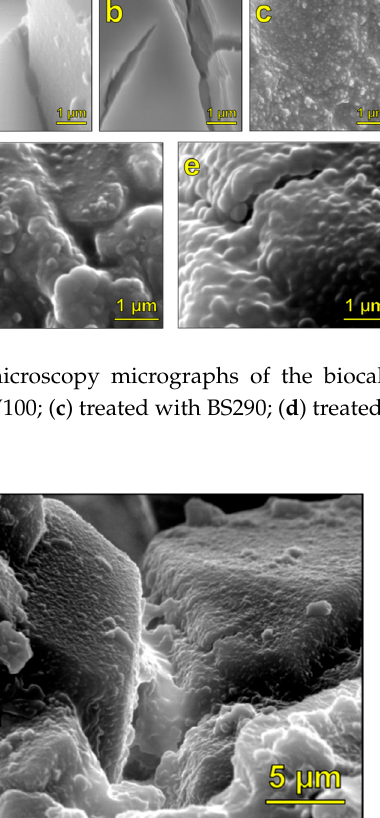
Figure 4. Scanning electron microscopy micrograph of the biocalcareous stone treated with UCA-TS. Nanomaterial bridges linking the quartz grains of the stone together can be clearly observed.